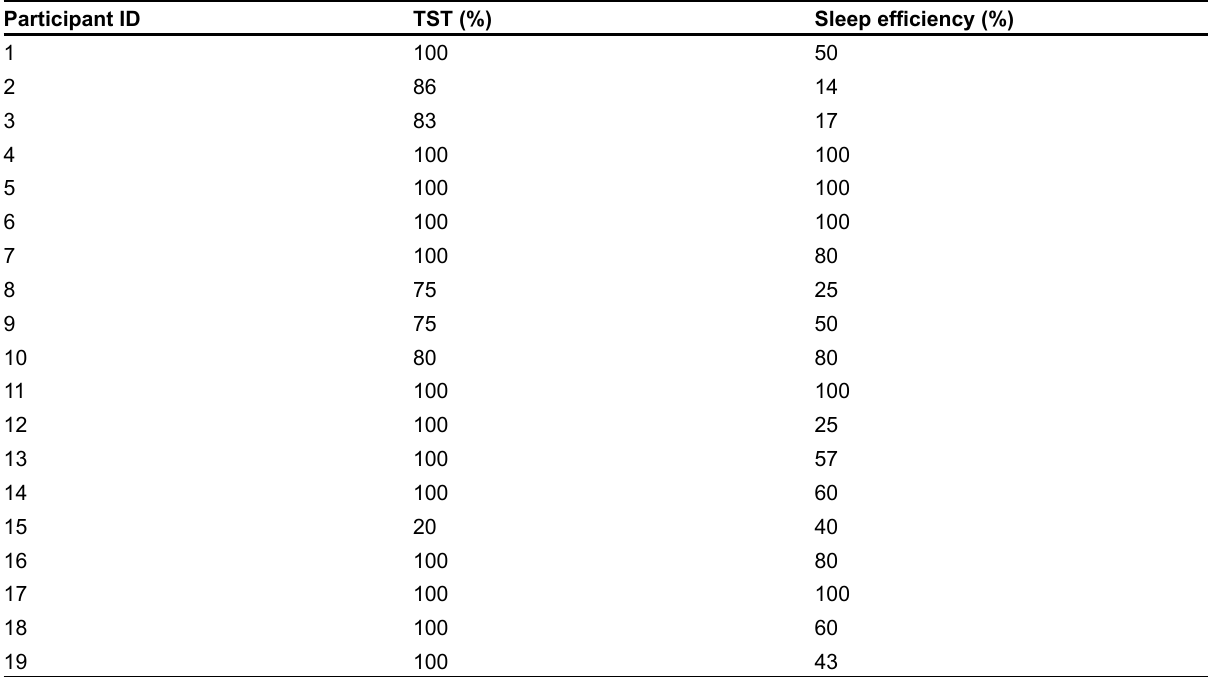
Figure 2. App vs. actigraph. Sleep Efficiency (Eff) Graph comparing sleep efficiency as measured by the Sleep Time App (M = 83.1, SD = 4.93) to sleep efficiency as measured by the actigraph (M = 78.8, SD = 6.90) Table 1. Percentage of time App overestimated TST and sleep